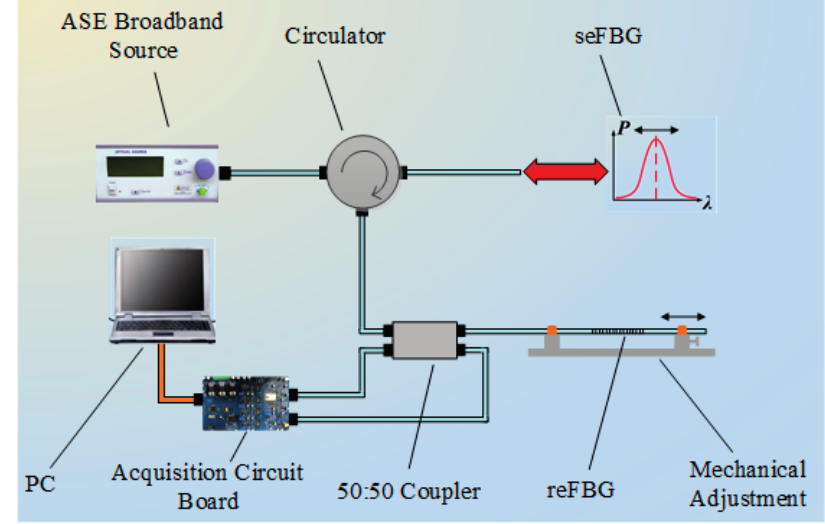
Figure 1. Schematic diagram of the FBG interrogation method based on a re fl ective-matched FBG